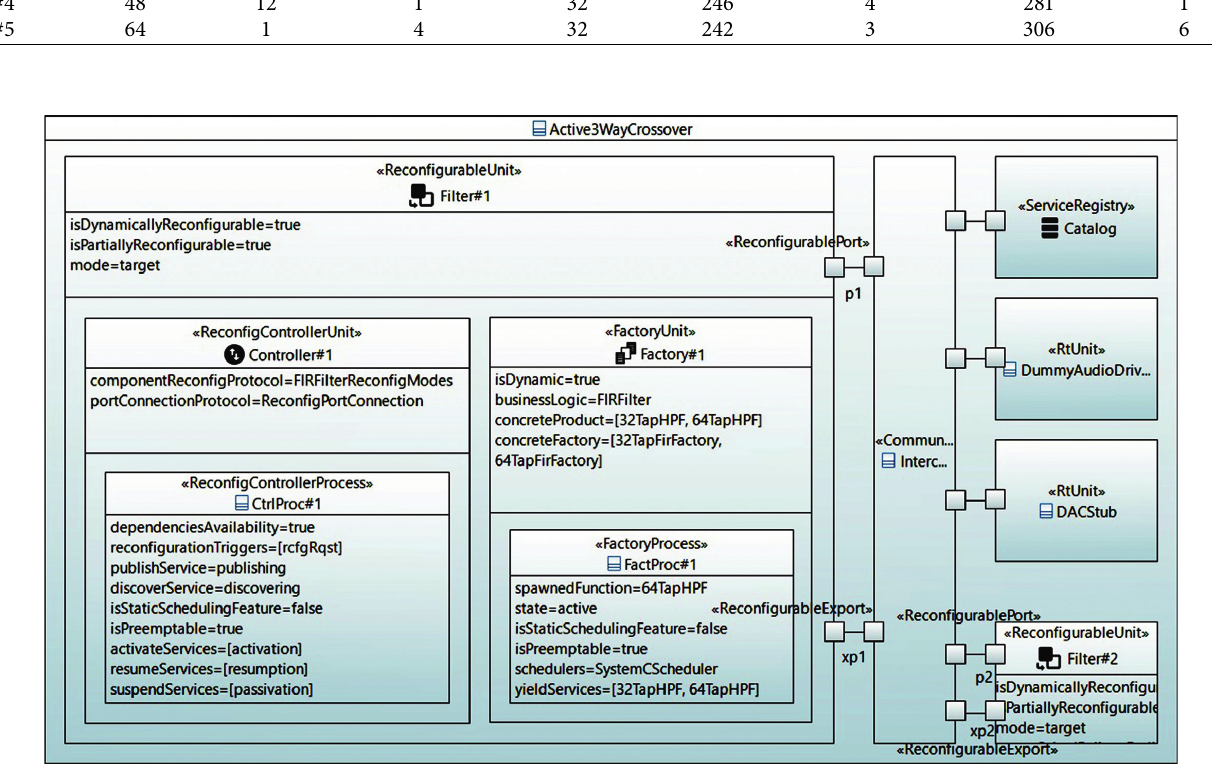
Figure 13: High-level abstract view.